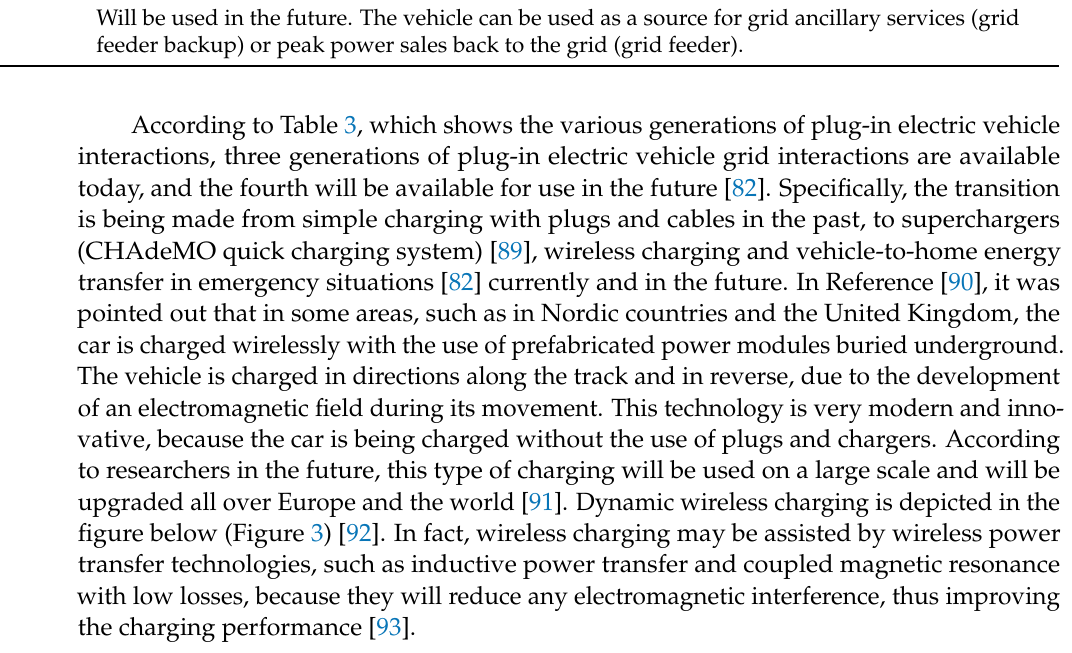
Table 3. Generations of plug-in electric vehicle (PEV) grid interactions [82].